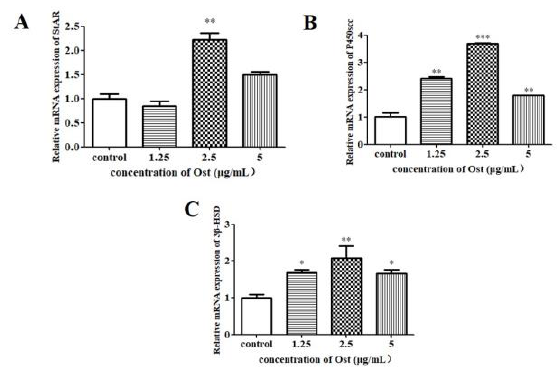
Figure 6. The mRNA expression of StAR ( A ), P450scc ( B ) and 3β-HSD ( C ) in granulosa cells treated with Ost for 24 h. qRT-PCR was performed and 2 − △△ Ct method was used for analysis. Data were expressed as Mean ± SEM. * p < 0.05, ** p < 0.01, *** p < 0.001.